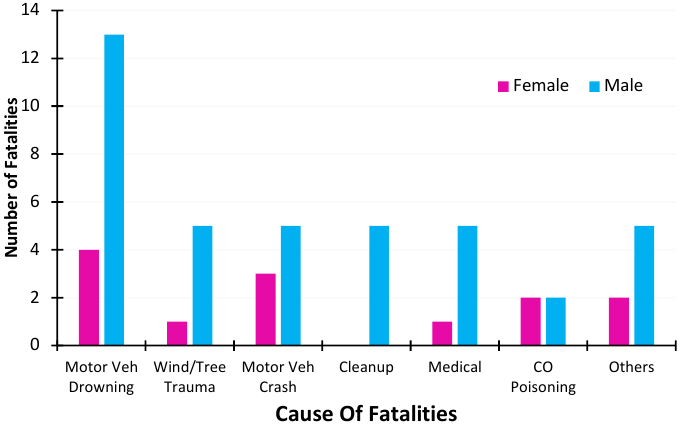
Figure 3. Gender distribution of the fatalities caused by hurricane Florence in North Carolina.